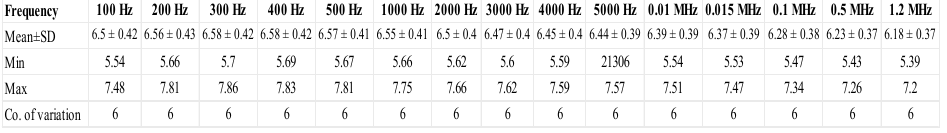
Figure 6. Capacitance readings for the tested oil samples, including base data for the results. The results indicate that the capacitance of the fresh motor oil samples was similar across all voltage frequencies, with any differences falling within the margin of random error. Mean capacitance readings range between 6.18 to 6.58 pF. The readings are notably stable in terms of coefficient of variation, with low values of approx. 6% in all cases. Con- sidering the quality characteristics of the results and their very low variation across the entire range of test voltage frequencies, this electrical parameter may prove the most suit- able for the testing and monitoring of motor oils. 3.6. Quality Factor The quality factor was also measured as a function of test voltage frequency. The results are shown in Figure 7.